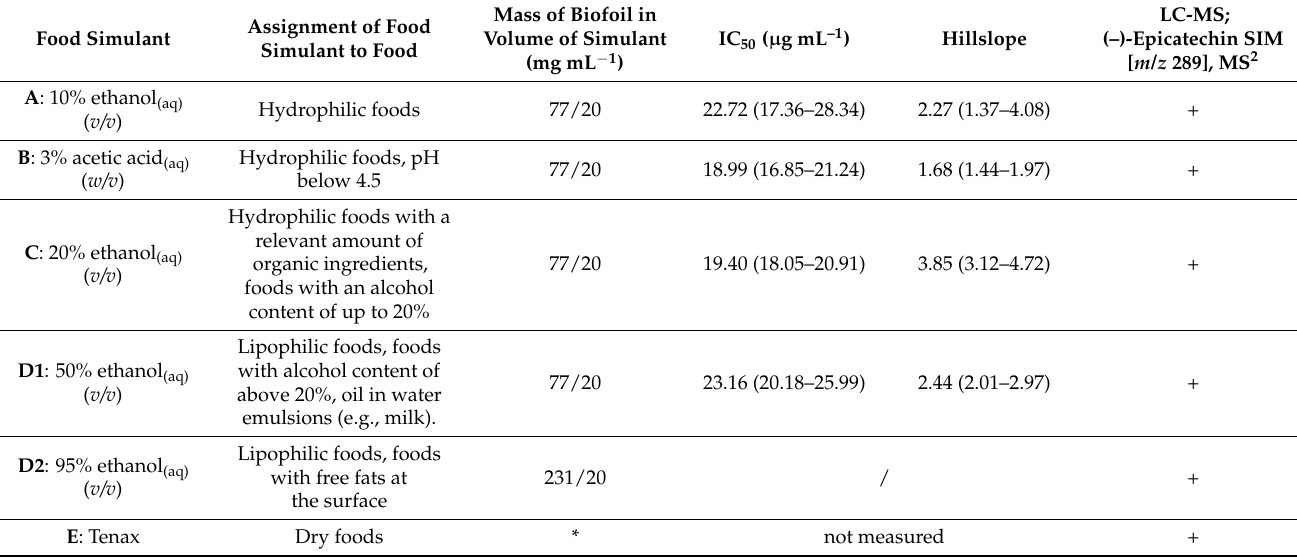
Table 1. Antioxidant activity of the food simulants, selected according to the European Commission’s document No 10/2011 [36], upon 1 h of contact with the formulated JKRB biofoil, and migration of the selected marker of the antioxidant activity, (–)-epicatechin, from the JKRB biofoil into food simulants. The food simulants in contact with the chitosan (blank) biofoil did not show antioxidant activity, except for food simulant E (not